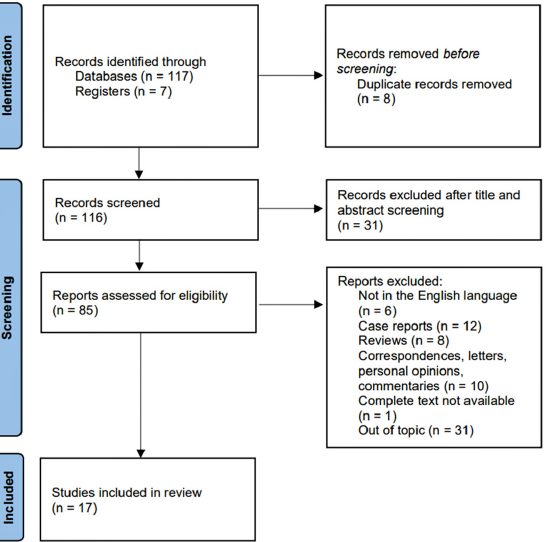
Figure 1. PRISMA flow diagram for selection process. A total of 124 studies were identified via electronic research. A total of 116 studies were eligible after duplicate removal, and 85 after title and abstract analyses. After checking all the inclusion and exclusion criteria, 17 studies were included in our review.